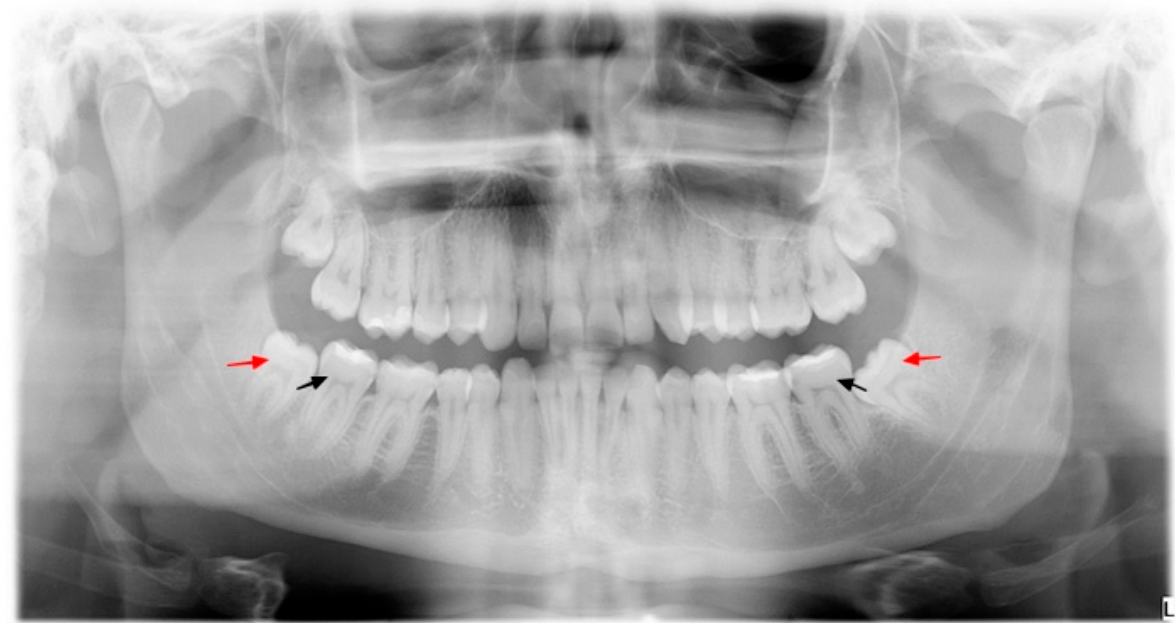
Figure 1. Orthopantomogram of a patient in the study group; red arrow—mandibular third molar, black arrow—mandibular second molar.